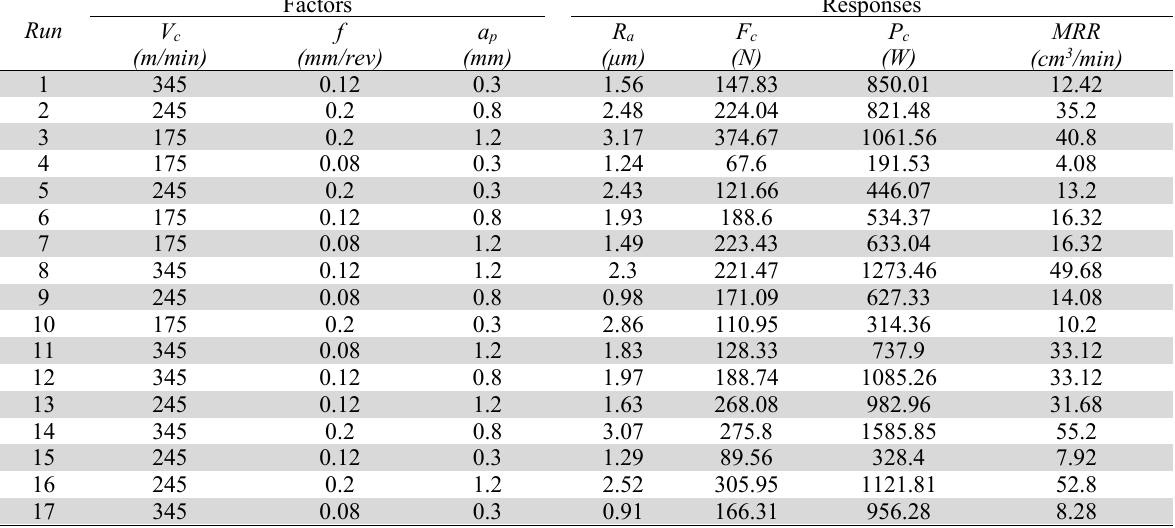
Experimental runs and results for Ra, Fc, Pc and